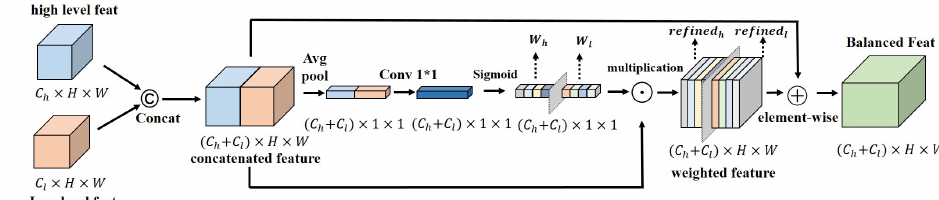
Figure 3. The structure design of the inter-level feature balanced fusion module. ©, (cid:12) , and (cid:76) respectively stand for concatenation, multiplication, and element-wise addition. The fusion weights of high-level features W h and low-level W l features are calculated